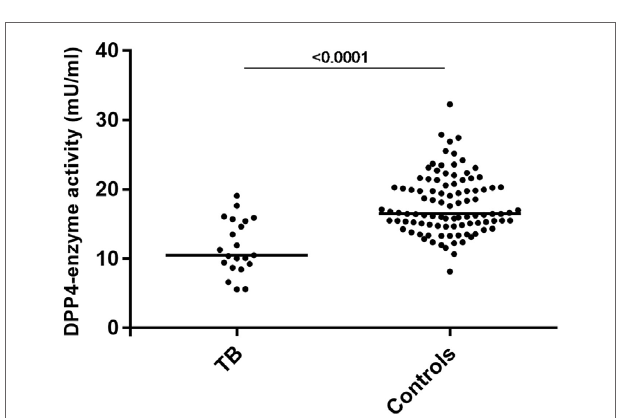
FigUre 2 | Correlation between CXCL10 short and long. Left panel: samples from the active tuberculosis patients; right panel: samples from pneumonia patients.